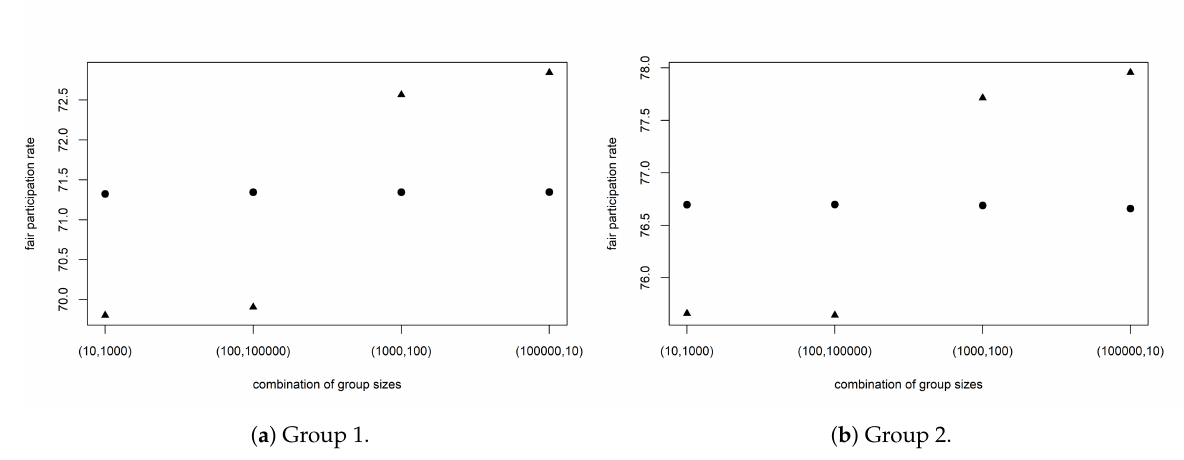
Figure 1. Case 1: fair participation rates in percentage when E Q [ ∆ ] = 0.8. Triangles show rates from Table 3 for given combinations of group sizes. Circles additionally show rates from Table 2 when group sizes ful-